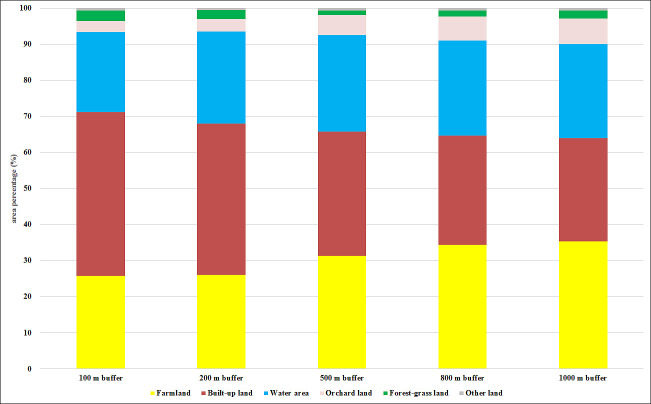
Proportional areas of LUTs at the buffer scales within each radius.